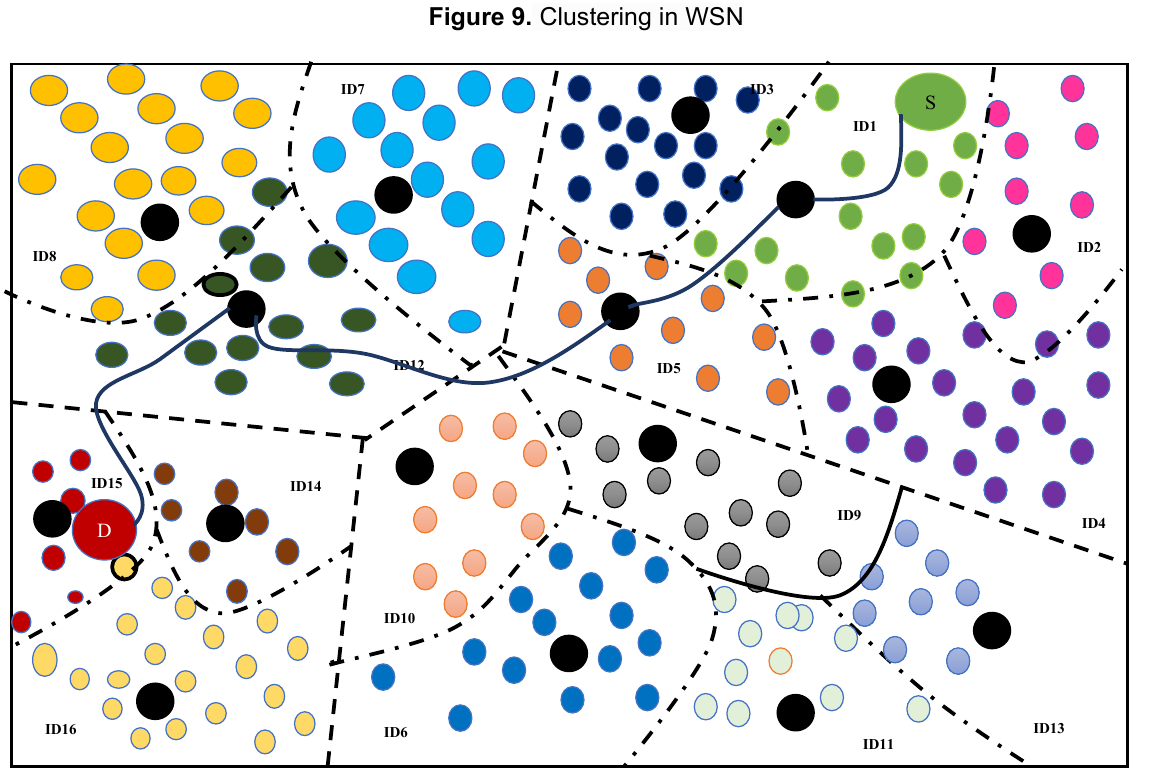
Figure 10. Route creation using